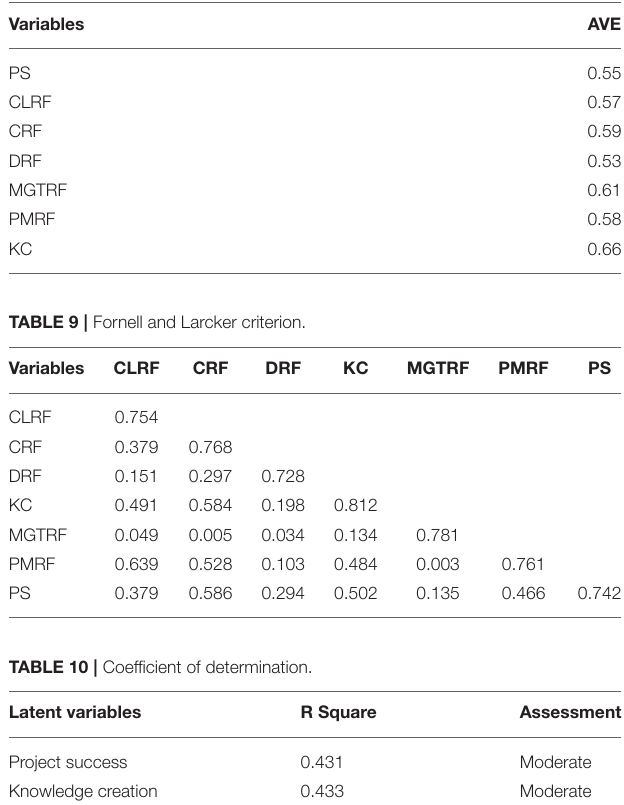
TABLE 8 | Convergent validity.